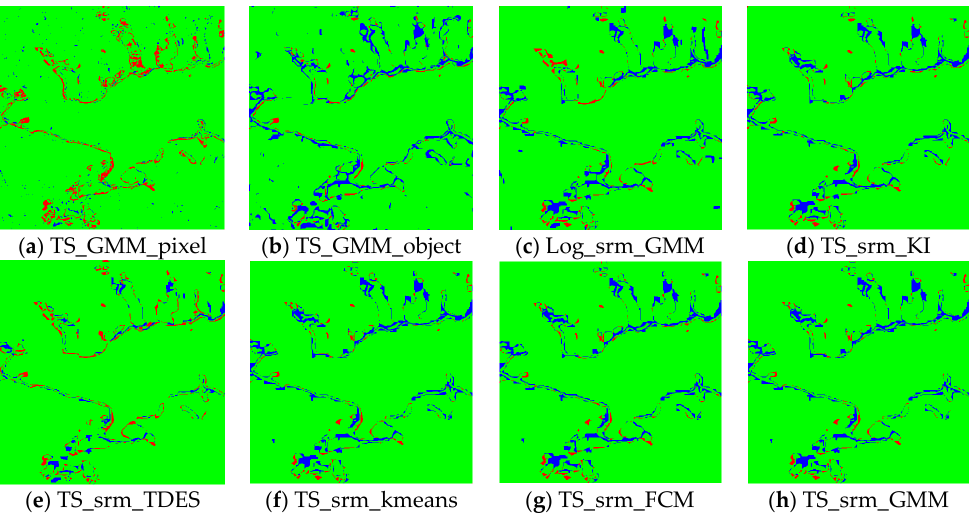
Figure 13. The qualitative comparisons change detection results of the different algorithms over LiangZi Lake.